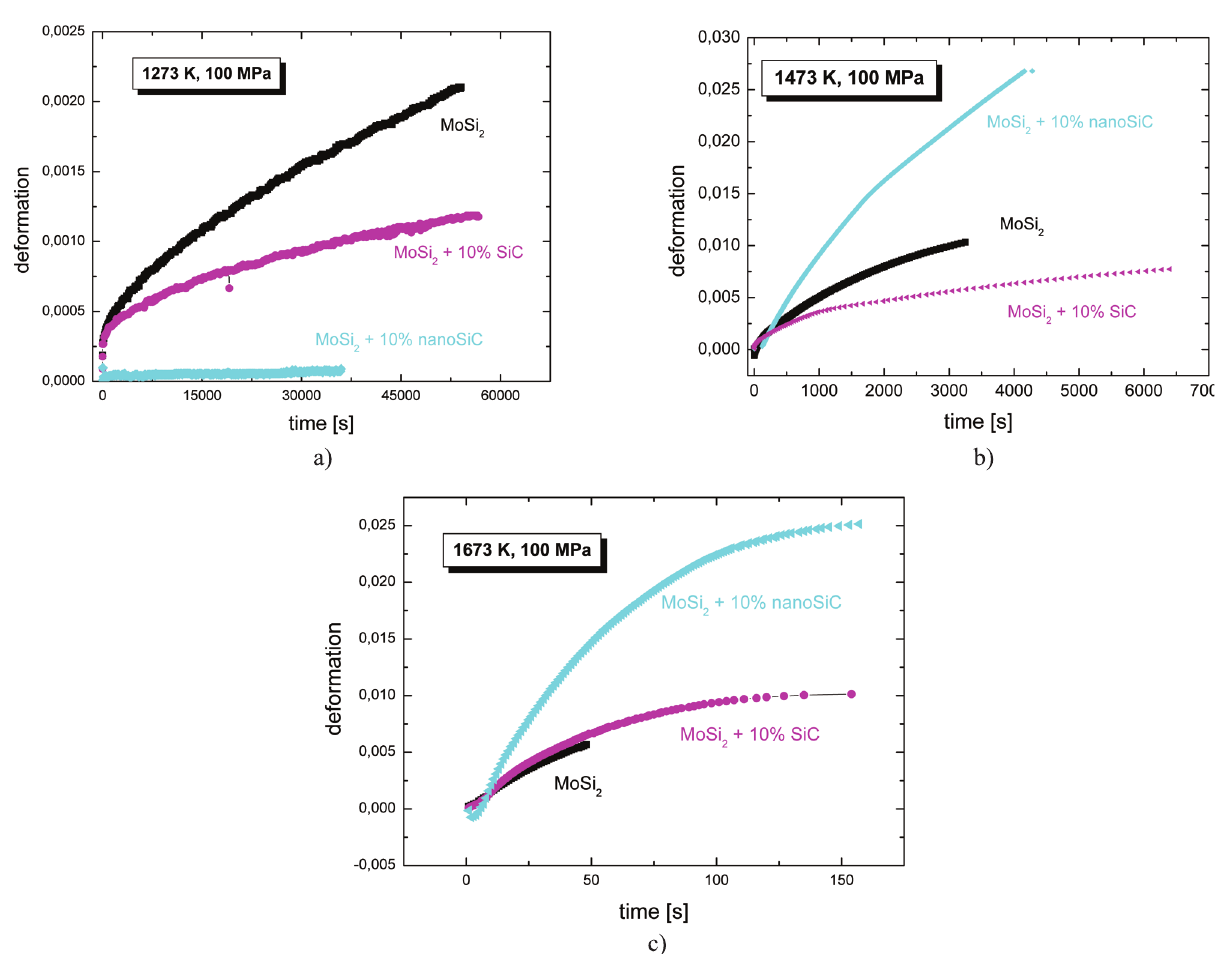
Fig. 2: Creep curves for studied materials under applied stress 100 MPa and a) temperature 1273 K, b) temperature 1473 K and c) temperature 1673